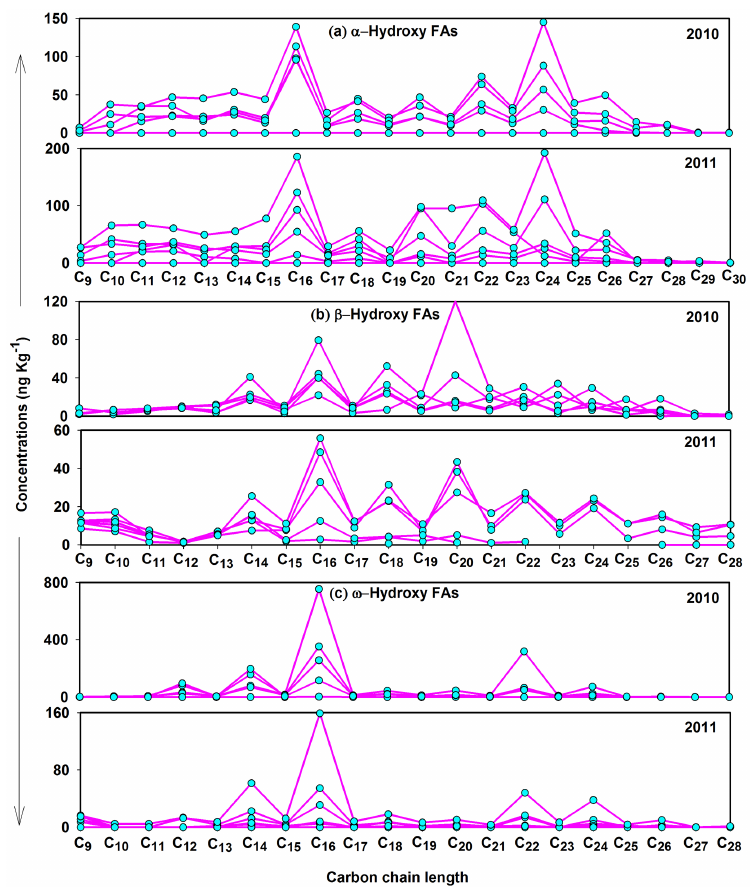
Figure 2. Molecular distributions of (a) α -hydroxy fatty acids (FAs) (C 9 –C 30 ) , (b) β -hydroxy FAs (C 9 –C 28 ) and (c) ω -hydroxy FAs (C 9 – C 28 ) in the snow samples collected from Sapporo during the winter of 2010 and